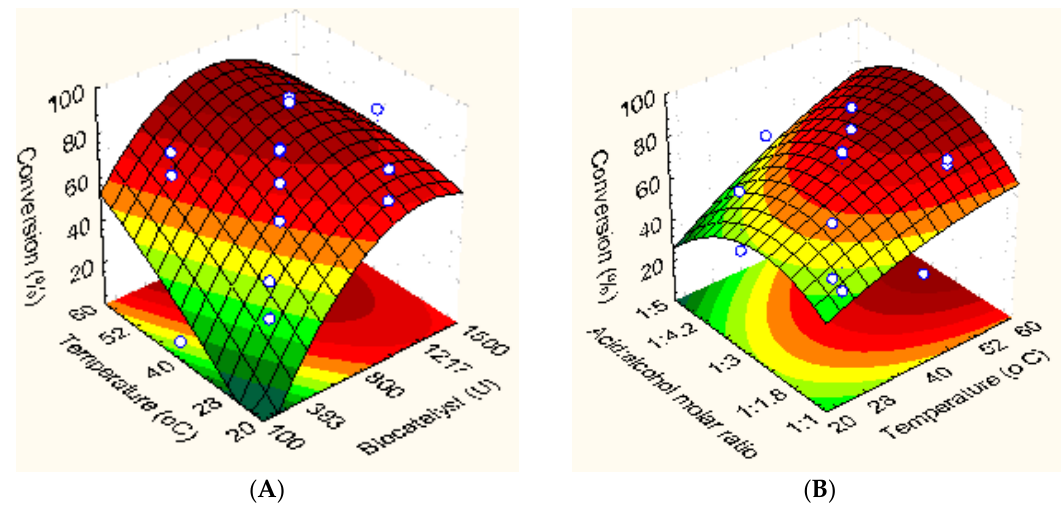
Figure 3. 3D surface and contour plots for ester synthesis. Effect of biocatalyst concentration and Figure3. 3Dsurfaceandcontourplotsforestersynthesis. E ff ectofbiocatalystconcentrationandreaction reaction temperature ( A ); and acid:alcohol molar ratio and reaction temperature ( B ) on the conversion temperature( A );andacid:alcoholmolarratioandreactiontemperature( B percentage.